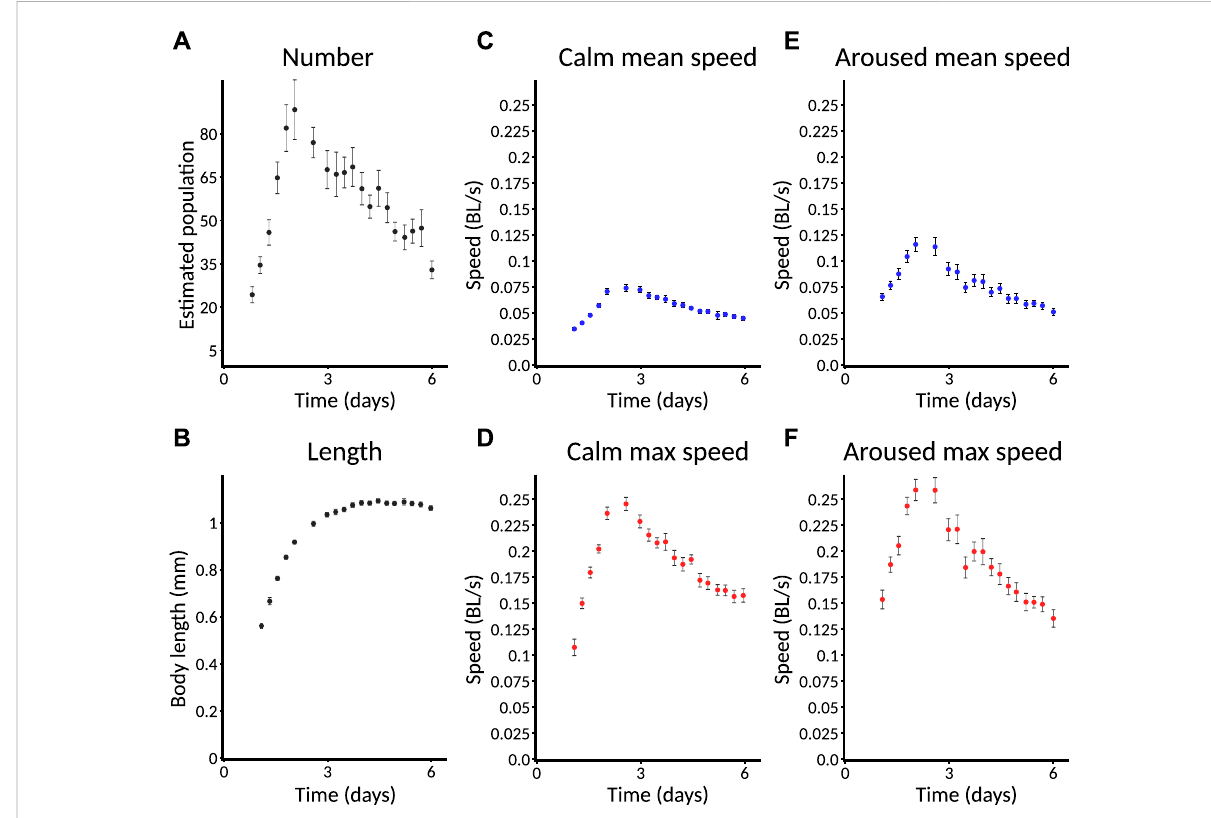
FIGURE 6 Selectedstandardbehavioralmeasures.PlatesimagedfromL1areusedasanexampleandarefollowedforonly6 days.ErrorbarsindicateSEM. Data from a plate are only included for plotting if at least three animals are detected on that plate. (A) Estimated number of animals. Animals are counted only if they move enough for their behavior to be quanti fi ed. Speci fi c speed scores may have a smaller sample size as not all animals are followed at all times. Error bars represent SEM. across plates, not within-plate error. (B) Length of animals. Note that data do not appear at the earliesttimepointsbecausetheanimalsaretoosmalltodetect. (C) Calmmeanspeed.Meanspeedofanimalsinmeasurementwindowshortlybefore taps are delivered (275 – 285 s), when animals have had time to return to baseline activity after the taps at the start of recording. (D) Calm maximum speed. Maximum speedofanimalsin (C) .Eachanimal ’ smaximum speediscomputedwithin thewindow;fromthese per-animalmaximumscores, a population mean and standard error are computed. (E) Aroused mean speed. Mean speed of animals in measurement window shortly after taps are delivered(440 – 450 s),whenanimalsstillexhibitoverallarousalinbehaviorfollowingrepeatedstimuli. (F) Arousedmaximumspeed.Maximumspeed of animals in (E) using the method described in (D)